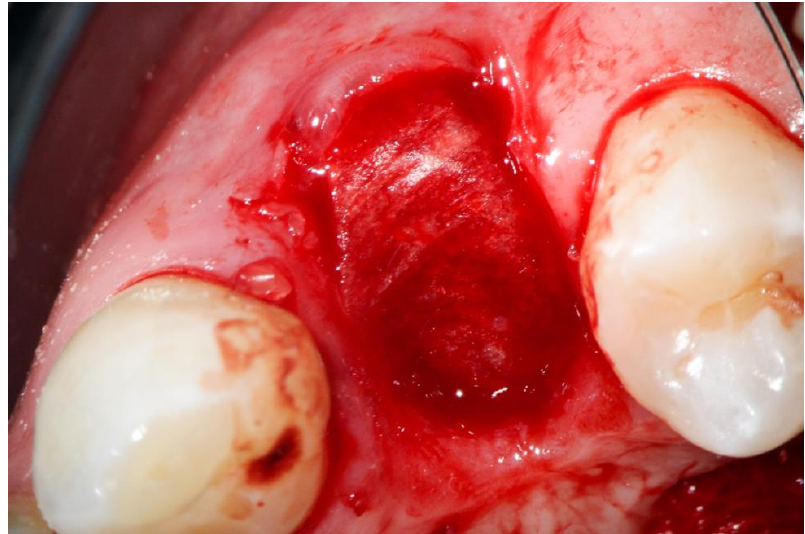
Figure 5. Collagen membrane adapted occlusally and palatally.